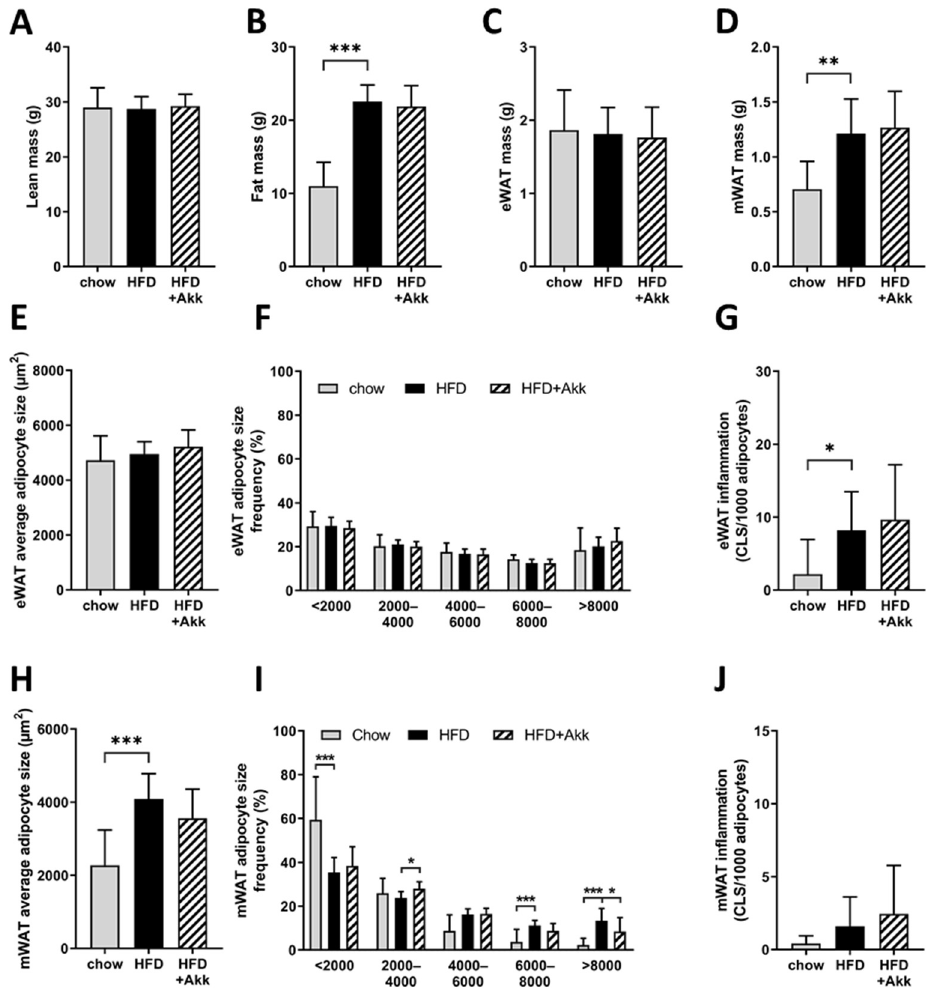
Figure 4. Heat-inactivated A. muciniphila did not affect adiposity but did improve adipocyte hypertrophy in the mesenteric depot. Ldlr − / − .Leiden mice were fed a chow reference diet (chow) or a NASH-inducing high-fat diet without (HFD) or with supplementation of heat-inactivated A. muciniphila (HFD + Akk) for 28 weeks. ( A ) Total lean mass; ( B ) total fat mass; ( C ) epididymal white adipose tissue (eWAT) mass and ( D ) mesenteric white adipose tissue (mWAT) mass at the end of the study; ( E ) average adipocyte size in eWAT; ( F ) distribution of eWAT adipocytes over 5 size ranges in µm 2 and ( G ) eWAT inflammation; ( H ) average adipocyte size in mWAT; ( I ) distribution of mWAT adipocytes over 5 size ranges in µm 2 and ( J ) mWAT inflammation. CLS: crown-like structures. Data shown are mean ± SD. * p < 0.05; ** p < 0.01; and *** p < 0.001 vs. HFD.